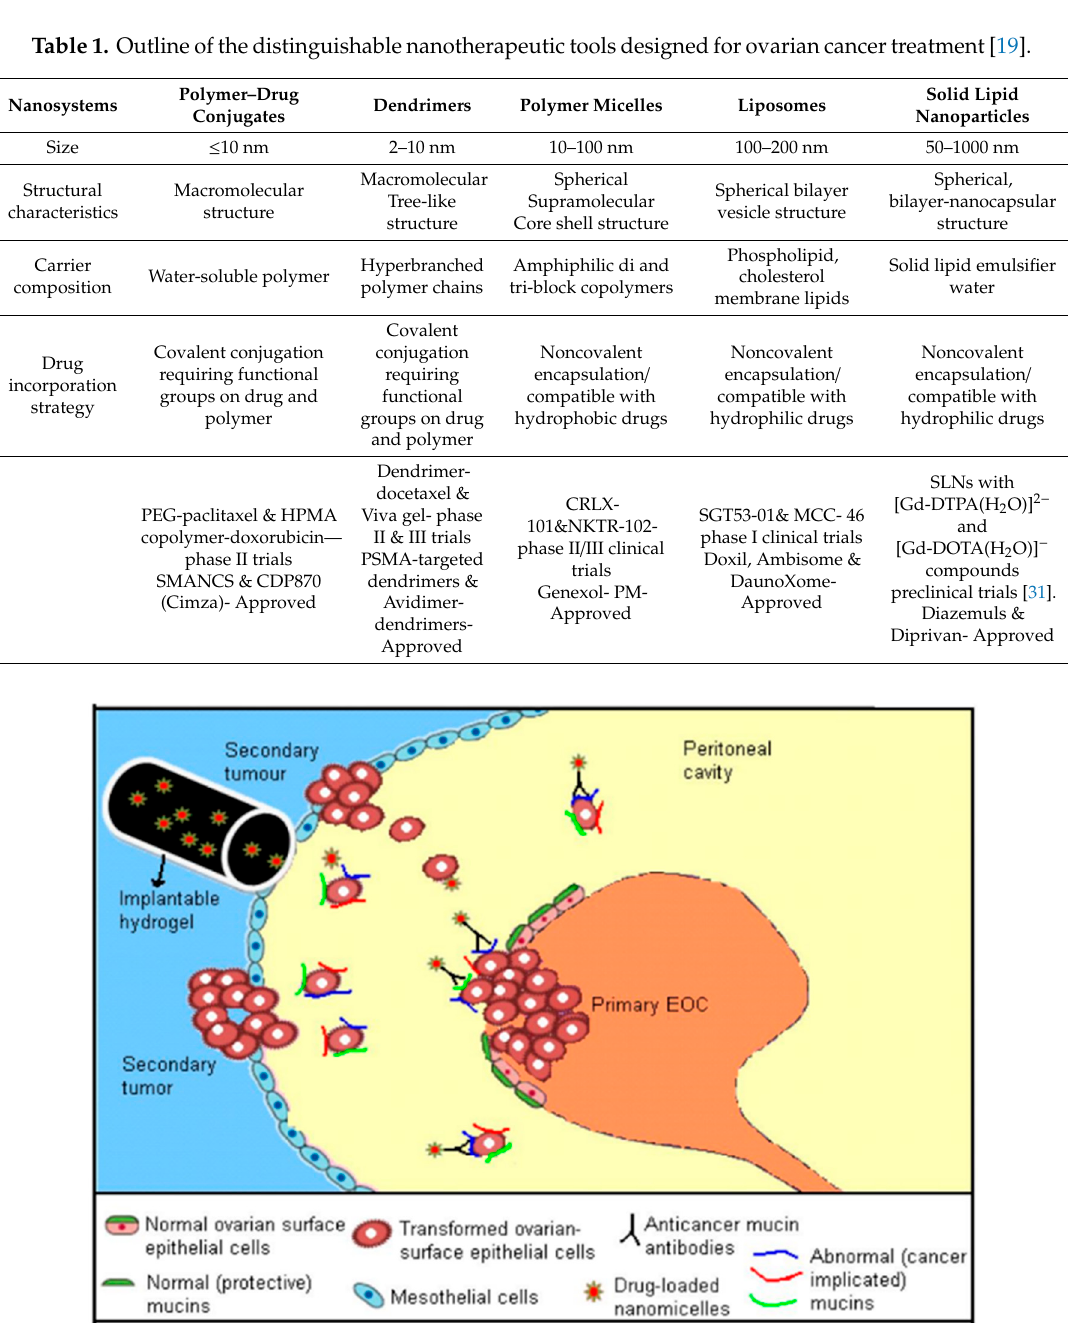
Figure 1. Illustration of the expression of cancer-associated mucins, accompanying the development of ovarian cancer and the intraperitoneal implant treatment, providing targeted therapy within the peritoneal cavity (Adapted with permission from [21].